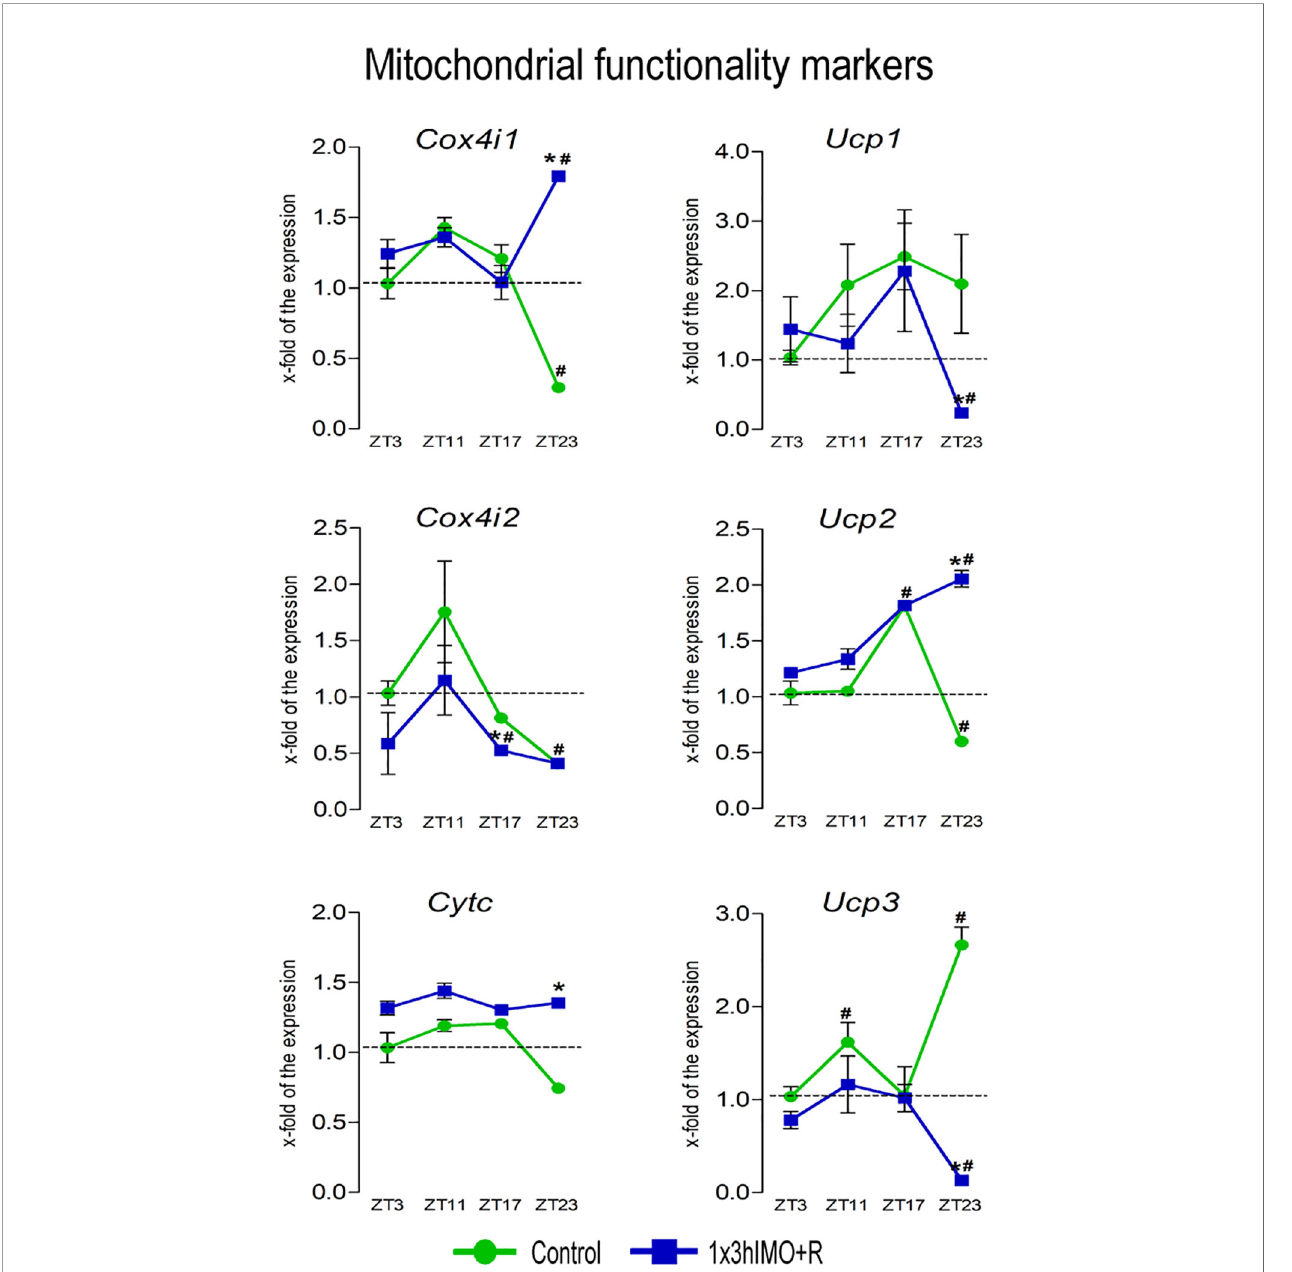
FIGURE 7 | Transcription of mitochondrial functionality markers is signi fi cantly changed in spermatozoa of acutely stressed adult rats in a time-dependent manner. Isolated RNA from spermatozoa of undisturbed and stressed rats was used for the analysis of the transcriptional pro fi le of markers of mitochondrial functionality. Data are presented as green dots connected with a green line for the control group, and blue squares connected with a blue line for the 1x3hIMO group, and are mean ± SEM values of two independent in vivo experiments. Statistical signi fi cance was set at p < 0.05: * vs. the control group of the same time point, # vs. the control group of ZT3 time stressed groups ZT17-1x3hIMO+R (1.6-fold compared to ZT17- Cox4i1 transcription signi fi cantly decreased in spermatozoa Control, 1.9-fold vs. ZT3-Control) and ZT23-1x3hIMO+R (2.4- from the ZT23-Control group (3.4-fold vs. ZT3-Control) but fold compared to ZT3-Control). increased in the ZT23-1x3hIMO+R group (6.1-fold compared to Cytc transcription signi fi cantly increased only in spermatozoa ZT23-Control, 1.8-fold vs. ZT3-Control). obtained from the ZT23-1x3hIMO+R group (1.8-fold compared Cox4i2 transcript level signi fi cantly decreased in spermatozoa to ZT23-Control). from the ZT23-Control (2.4-fold vs. ZT3-Control) as well as the